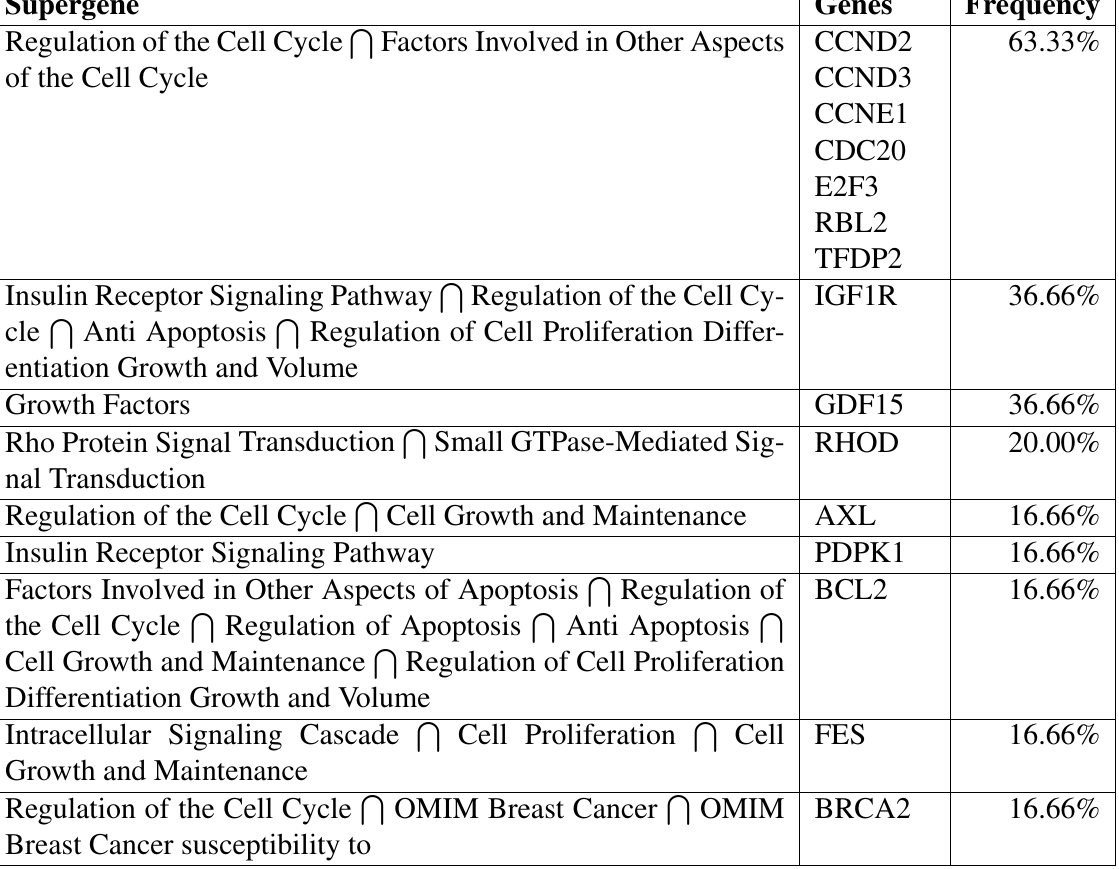
Table 2: Top selected